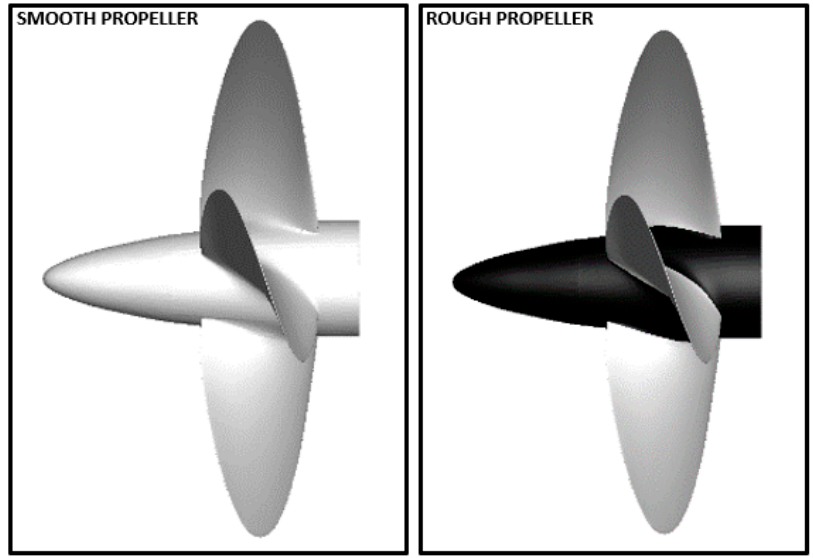
Figure 1. Representation of the roughness application area on the hub (black colour represents the area where the roughness was applied).